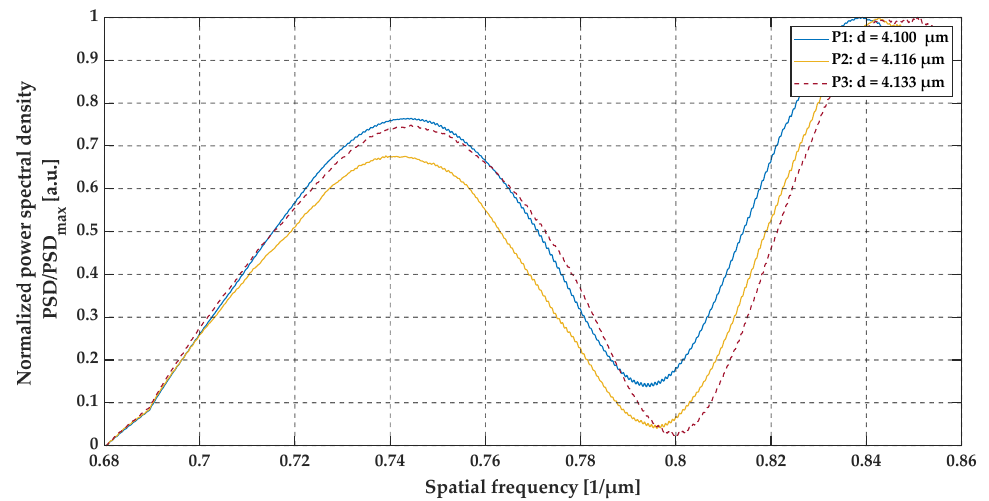
Figure 16. The envelopes of preprocessed data at positions P1, P2, and P3.